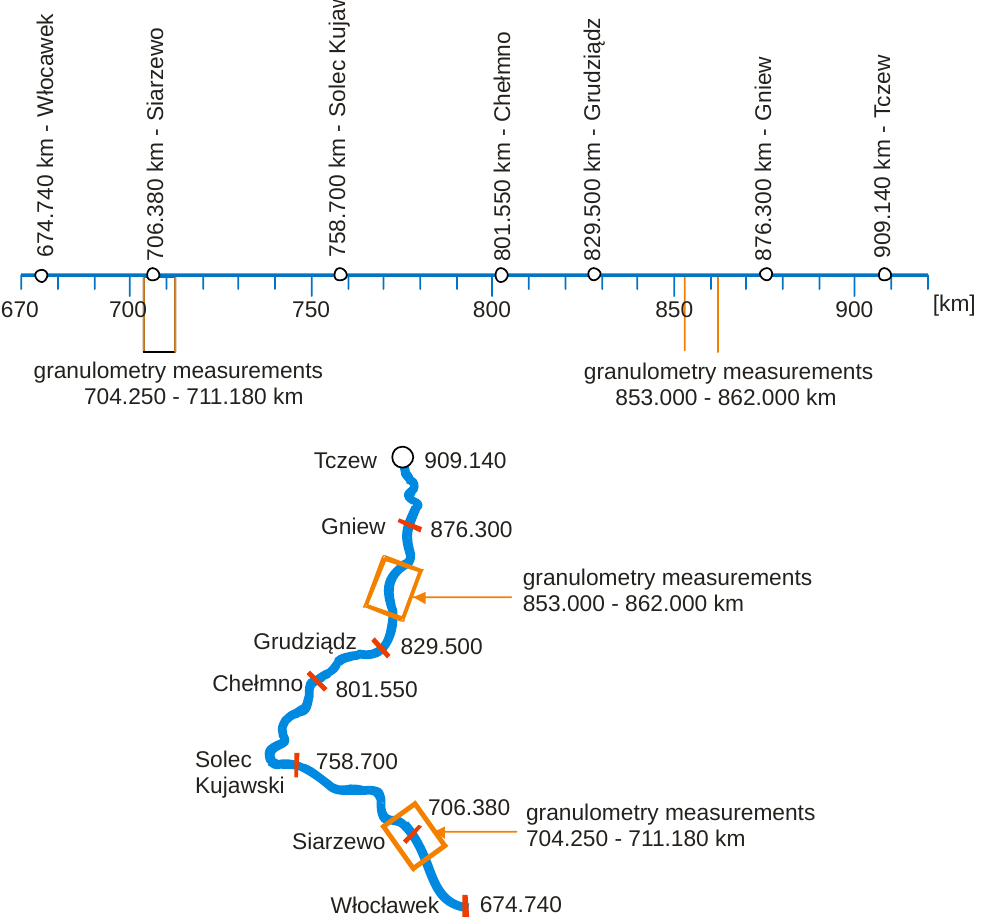
Figure 6. Granulometric measurements sites and locations of planned dams of the Lower Vistula